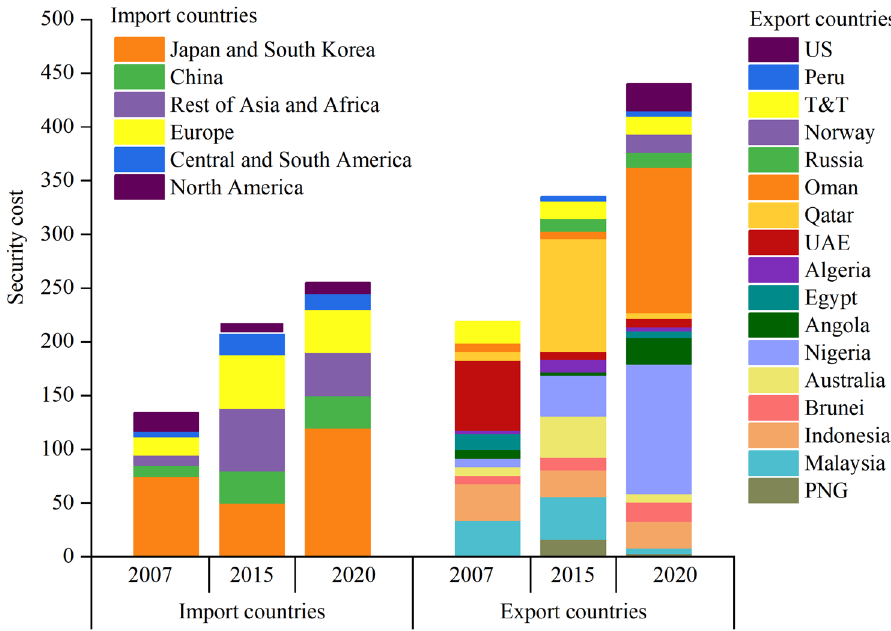
Figure 3. The export/import security costs of various LNG trading countries in different